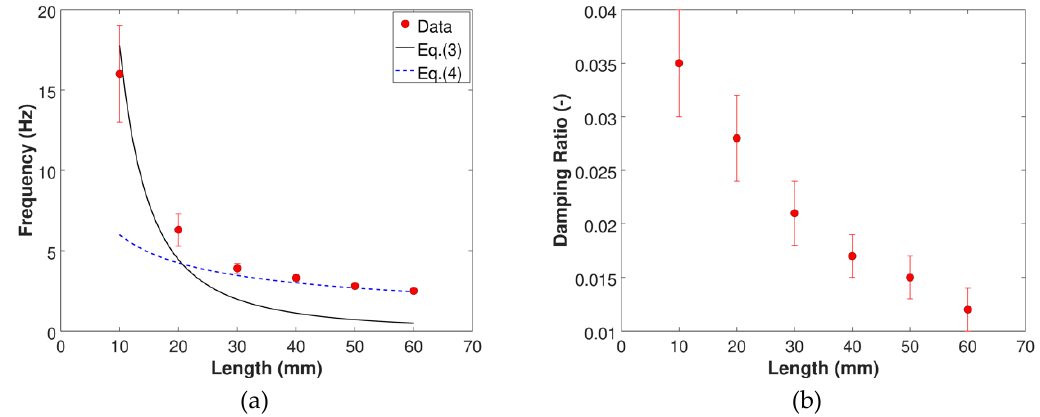
Figure 3. Preliminary characterization of the flexible filaments. ( a ) First-mode natural vibration frequency; ( b ) First-mode damping ratio in stagnant air.